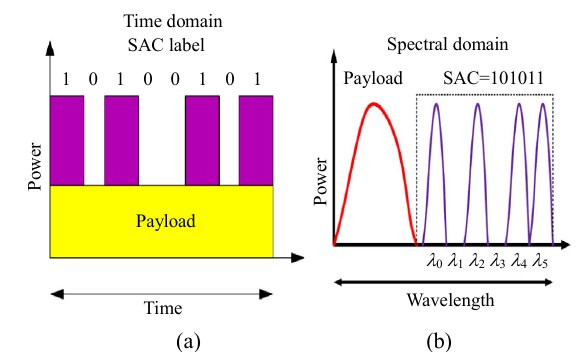
Fig. 1 Schematic diagrams of SAC label: (a) time domain and (b) wavelength